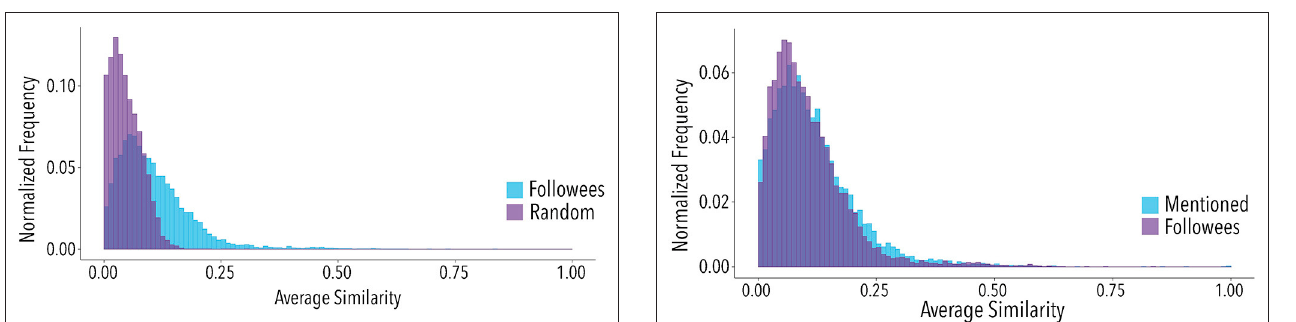
FIGURE 4 | Distributions of average similarity between users followed (purple) and mentioned (blue) by central users. KS = 0.06, p < 0.001. Distributions have been calculated considering the whole set of 9,490 central